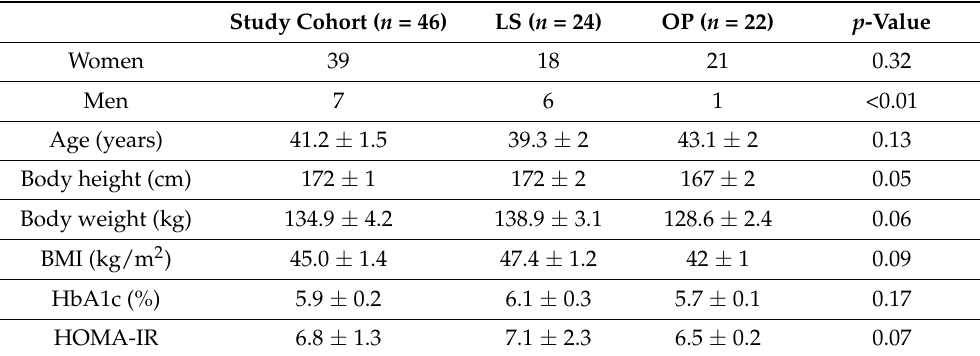
Table 1. Medians ± interquartile range (IQR) of baseline characteristics with standard deviation of patients enrolled in the WAS trial. Study Cohort ( n =